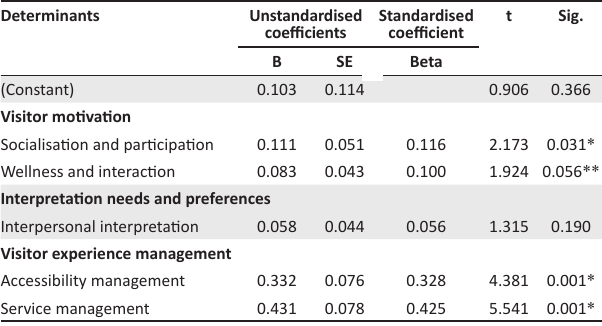
TABLE 6: The determinants of enhanced conservation